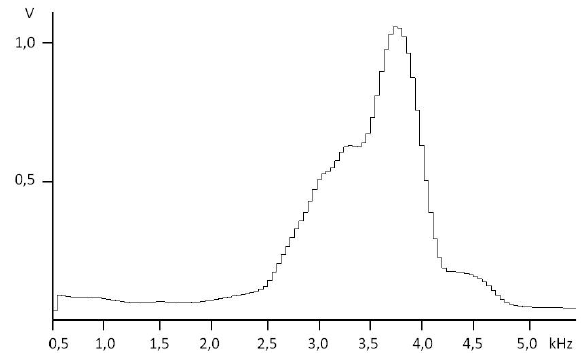
Figure 10. Power spectrum of an advertisement call from Choe- rophryne multisyllaba sp. n